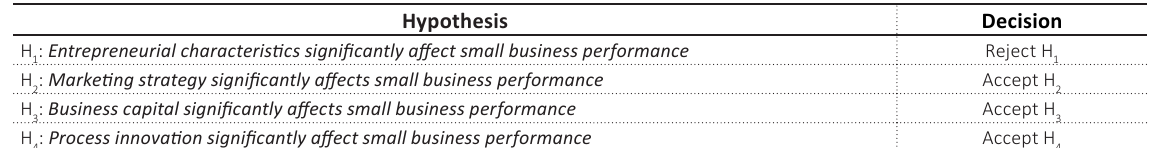
Table 3. Hypothesis